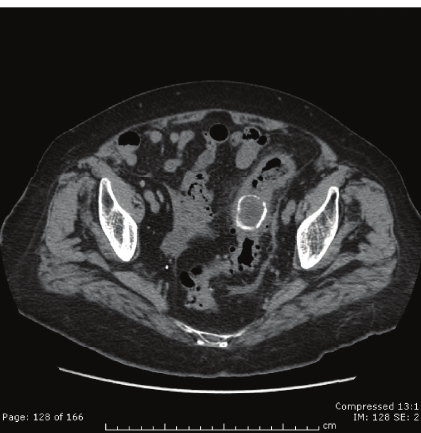
Figure 1: Computed tomography. Gallstone impacted in the sig- moid colon.